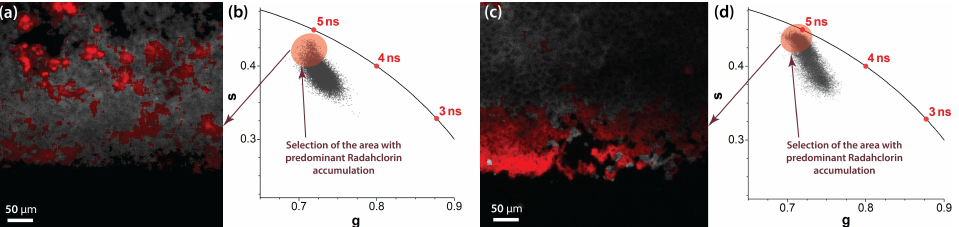
Figure 4. Selection of the areas close to the semicircle of the phasor plot allows the identification of areas of predominant Radachlorin accumulation. Examples of fluorescent images ( a , c ) and corre- sponding phasor plots ( b , d ) with predominant accumulation of Radachlorin PS in the samples of photosensitized tumor tissue ( a , b ) and photosensitized testicular tissue ( c , d